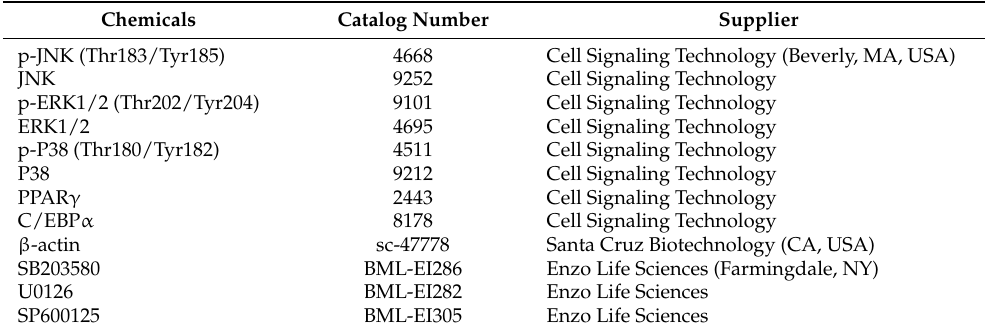
Table 1. The detailed information about the antibodies we